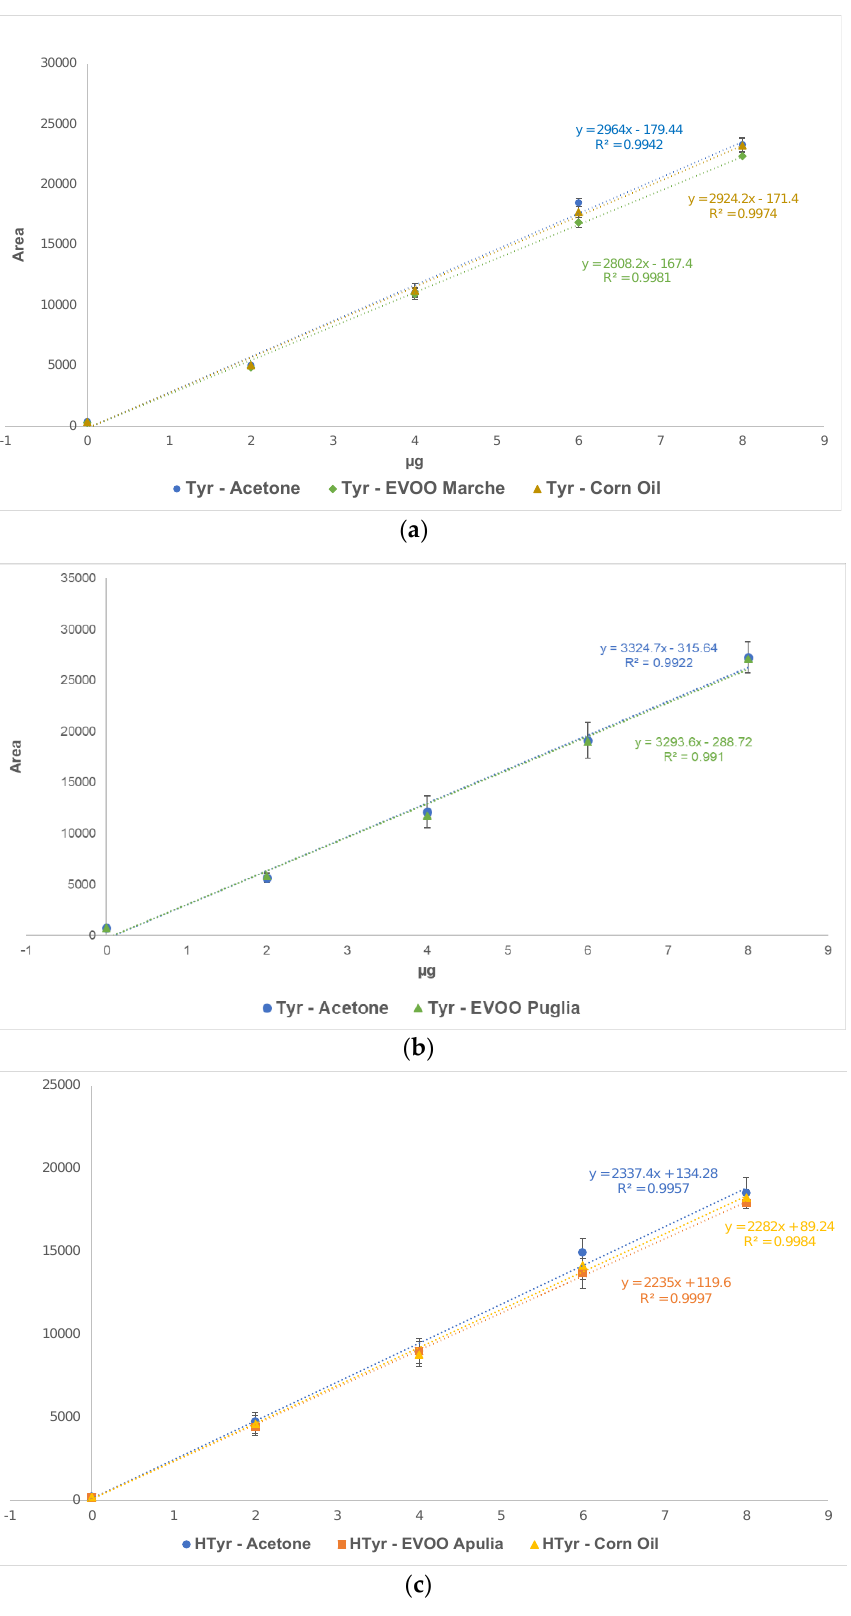
Figure 2. Matrix effect evaluation. Comparison of standard addition calibration curves: ( a ) Tyr in solvent (blue line), EVOO Marche (green line), and corn oil (yellow line); ( b ) Tyr in solvent (blue line) and EVOO Apulia (green line). ( c ) Htyr in solvent (blue line), EVOO Apulia (orange line), and corn oil (yellow line).